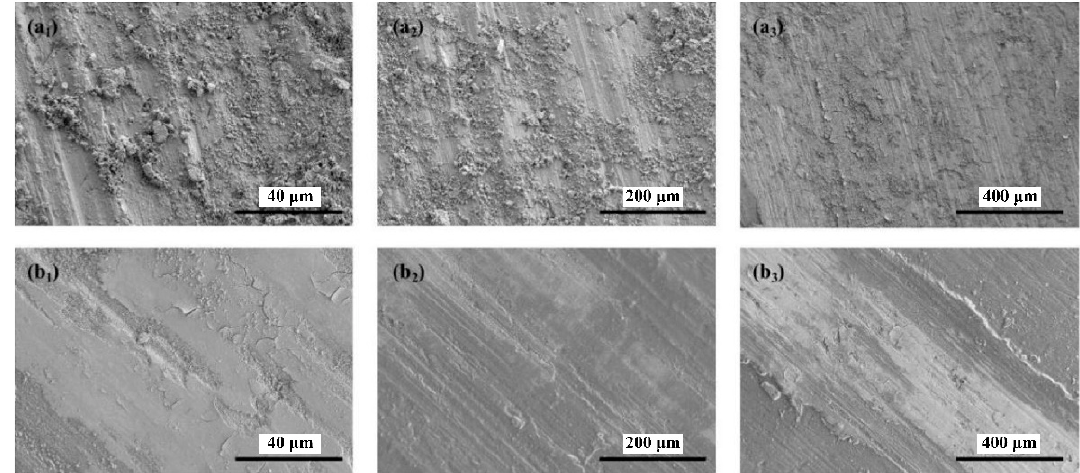
Figure 16. The SEM images of the wear scar on the aluminum plates with: ( a 1 – a 3 ) the distilled water; and ( b 1 – b 3 ) the 2 wt.% JD2000 aqueous solution.